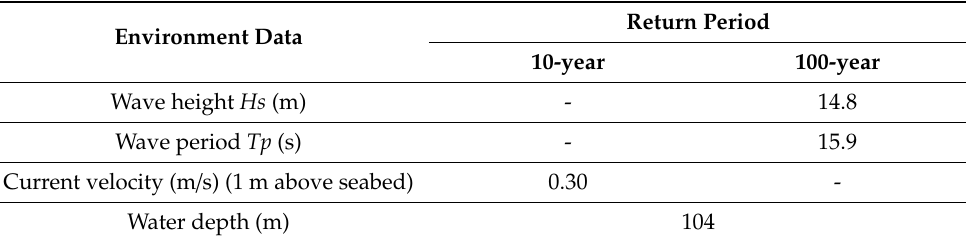
Table 3. Environment